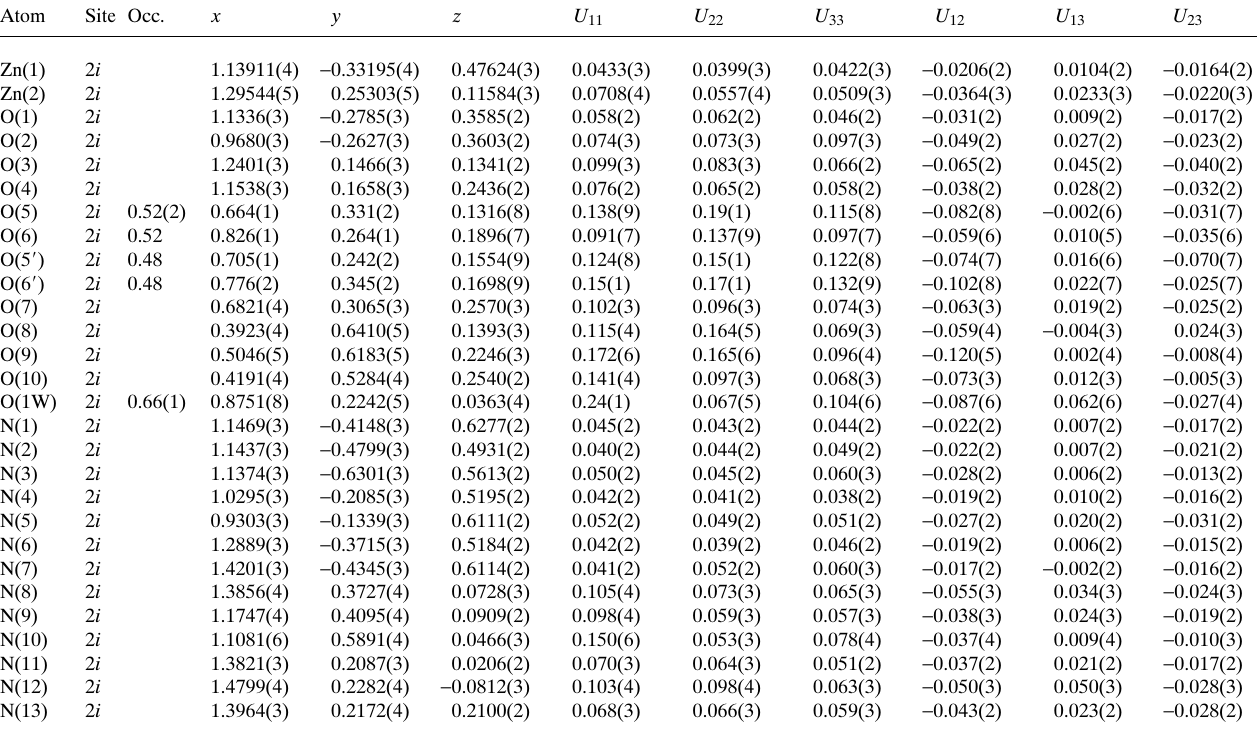
Table 3. Atomic coordinates and displacement parameters (in Å 2 ) .